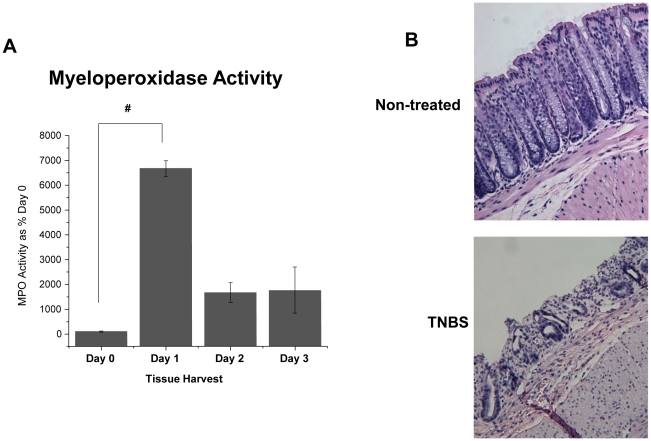
TNBS-induced inflammation in C57BL/6 Mice.Inflammation was induced by TNBS (1.5 mg, in 50% ethanol solution) and animals were monitored for: A) Colonic tissue was collected and assessed for MPO activity (N = 4, except Day 1, N = 3). Data are expressed as % Day 0 Control ± SEM. # Statistical difference (p<0.001). B) Representative histological images of colonic tissue from C57BL/6 mice 24 hours following TNBS administration showing colonic inflammation (Mag 100×).